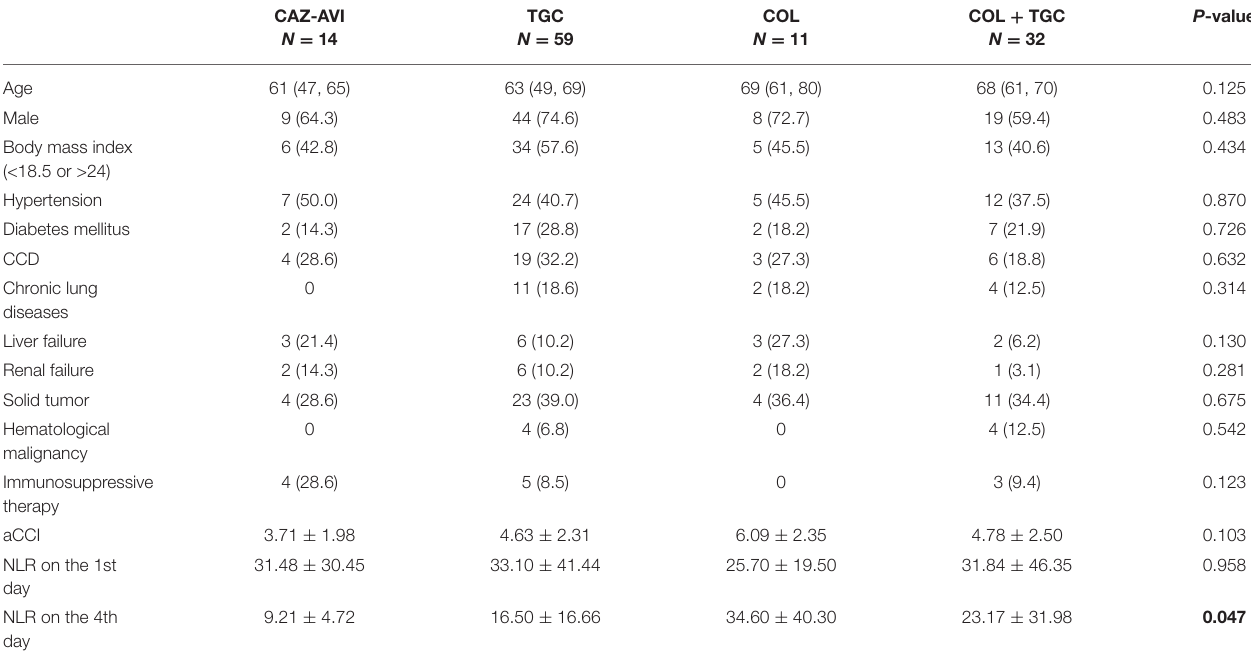
TABLE 3 | Baseline characteristics and NLR of 116 patients treated with